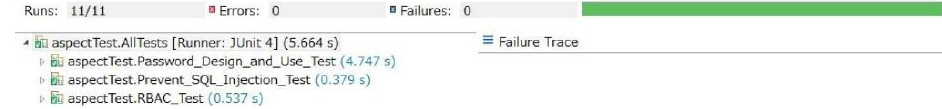
Figure 15. Re-test results.